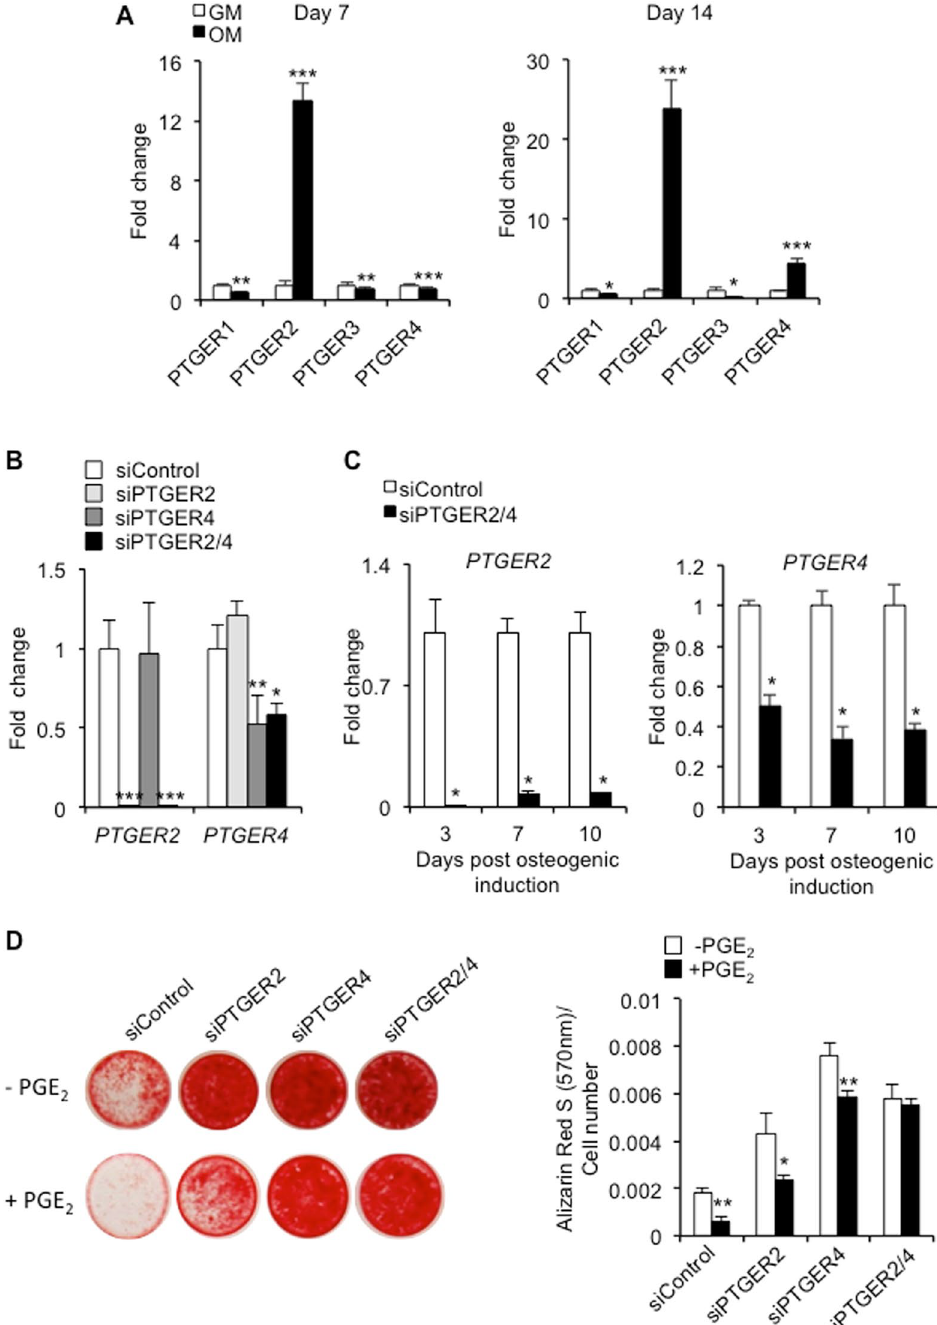
Figure 4. PGE 2 effects are mediated through specific PGE 2 receptor subtypes. ( A ) hBMSC were cultured in growth medium (GM) or osteogenic medium (OM), and PGE 2 receptor gene expression levels determined at day 7 and 14 using RT-qPCR. * p < 0.05, ** p < 0.01, *** p < 0.001 as compared to GM using Student’s t-test. ( B ) RT-qPCR was used to assess the short-term effects (48 h) of siRNA specific for PTGER2 (siPTGER2), PTGER4 (siPTGER4) or both PTGER2 and PTGER4 (siPTGER2/4) on PTGER2 and PTGER4 gene expression in hBMSCs undergoing osteogenesis. * p < 0.05, ** p < 0.01, *** p < 0.001 as compared to cells treated with scrambled control siRNA (siControl) using ANOVA. ( C ) RT-qPCR was used to assess the long-term effects (3, 7 and 10 days) of siRNA specific for both PTGER2 and PTGER4 (siPTGER2/4) on PTGER2 and PTGER4 gene expression in hBMSCs undergoing osteogenesis. * p < 0.001 as compared to cells treated with scrambled control siRNA (siControl) using Student’s t-test. ( D ) The effects of continuous PGE 2 (10 nM) treatment on matrix mineralization in siRNA-treated hBMSCs was assessed at day 15 by Alizarin Red S staining. * p < 0.01, ** p < 0.001, as compared to untreated hBMSCs ( − PGE 2 ) using Student’s t-test. The data represent triplicate determinations and were replicated at least two times. All values are presented as mean ±